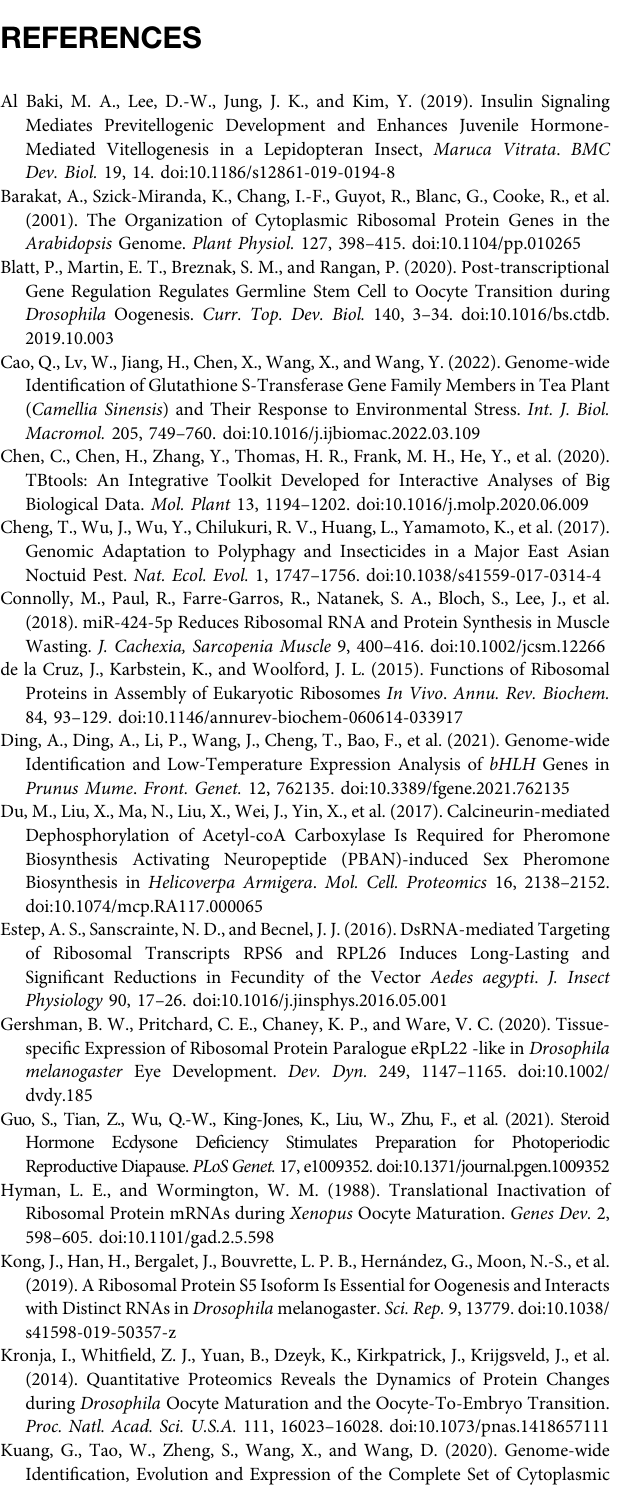
SupplementaryFigureS1| Phylogeneticanalysisof Sl Rpswithother fi veinsects. Bm , B. mori ; Sf , S. frugiperda ; Ha , H. armigera ; Px P. xylostella ; Dm , D. melanogaster . The phylogenetic NJ tree was constructed using the MEGA X software with the neighbor- joining method. The bootstrap values are 1000 replicates.